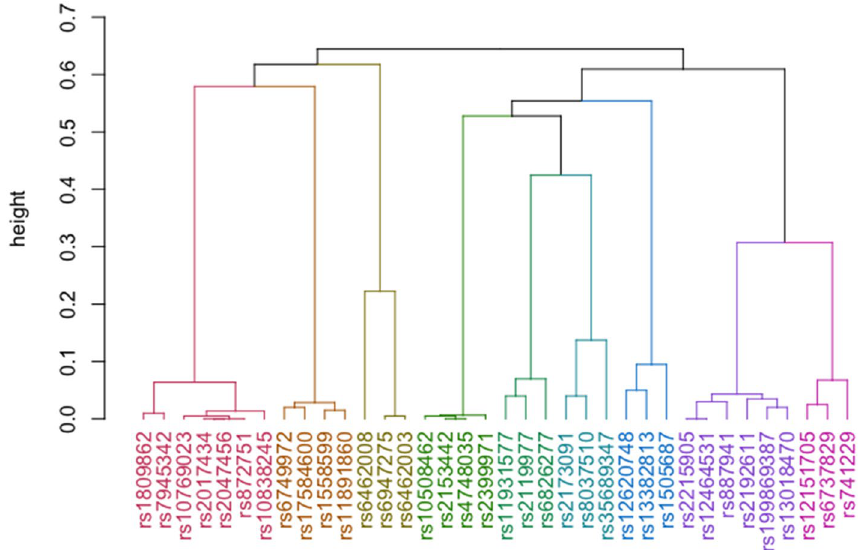
Figure 2. Dendrogram of the SNPs listed in Table 2.